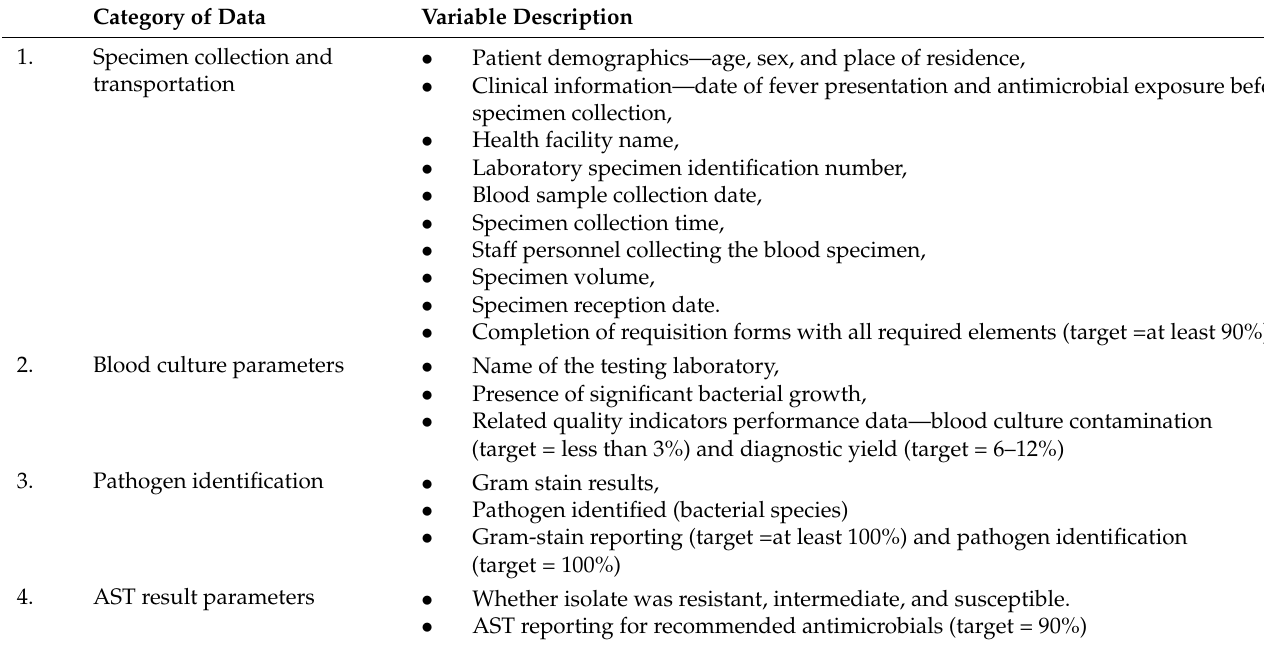
Table 1. Summary of study data